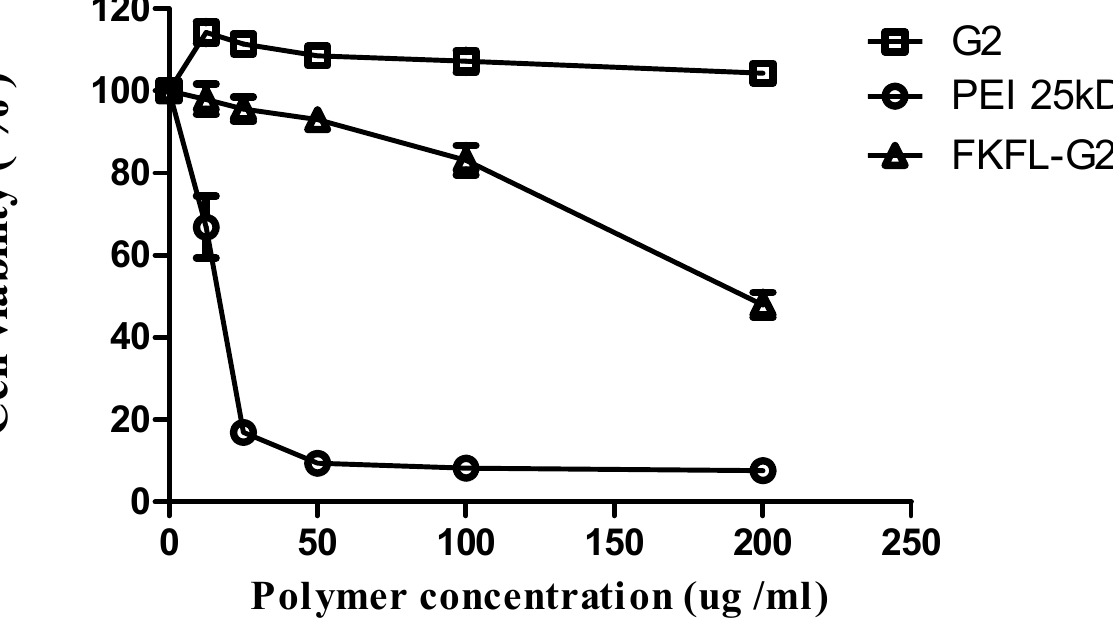
Figure 3. Cytotoxicity of FKFL-G2 in NIH3T3 cells, determined using an EZ-Cytox reagent assay. The data of the data points represent the means ± SD ( n = 4).